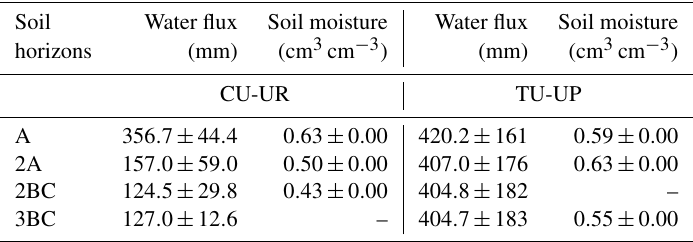
Figure 7. Simulated water fluxes over the period December 2018–March 2021 (a, c) for the two soil profiles. A snapshot is shown in panels (b, d) to highlight the response during rainfall events. The rainfall is represented by the blue line. Brown and black colors represent the A and 2A horizons for both soil profiles. The yellow and purple lines represent the 2BC and 3BC horizons for the CU-UR and TU-UP profiles, respectively. The water fluxes are derived for the bottom of the soil horizons. Table 4. Mean annual simulated water fluxes and measured volumetric water content (January–December 2019 to January–December 2020) by soil horizon (mean ± 2standard